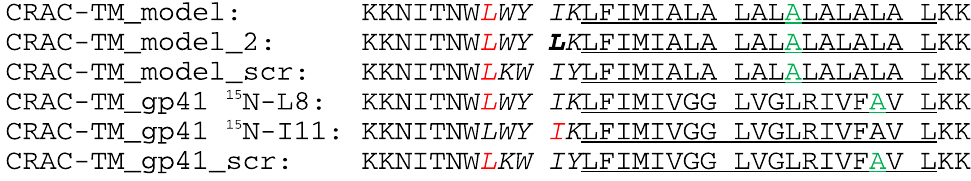
Table 1. Peptides derived from gp41 and investigated in this paper ( Env HV1H2 UniProtKB–P04578; residues 674–702 or parts thereof). The CRAC motif is shown in italics, the transmembrane domain is underlined. 15 N labelled sites are shown in red, 2 H 3 -alanines in green. The substituted leucine of the CRAC variant is shown in